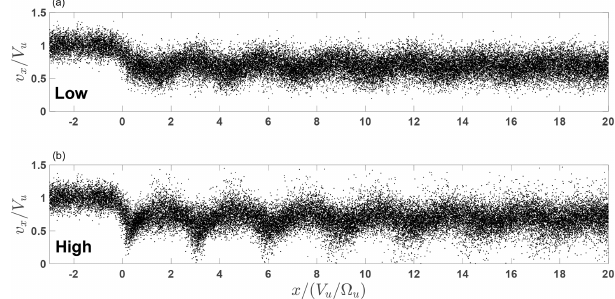
Figure 2. Velocity v x of ions for the low (a) and high (b)